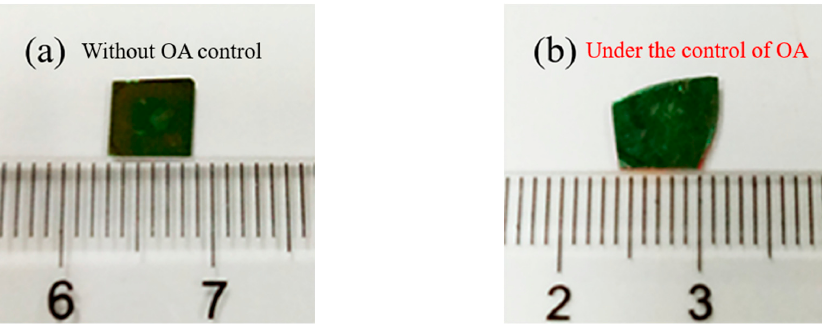
Figure 2. Photographs of the largest DAST single crystals grown ( a ) without the OA control (5.8 × 5.5 × 0.9 mm 3 ), and ( b ) under the control of the OA (11 × 8 × 1.2 mm 3 ).